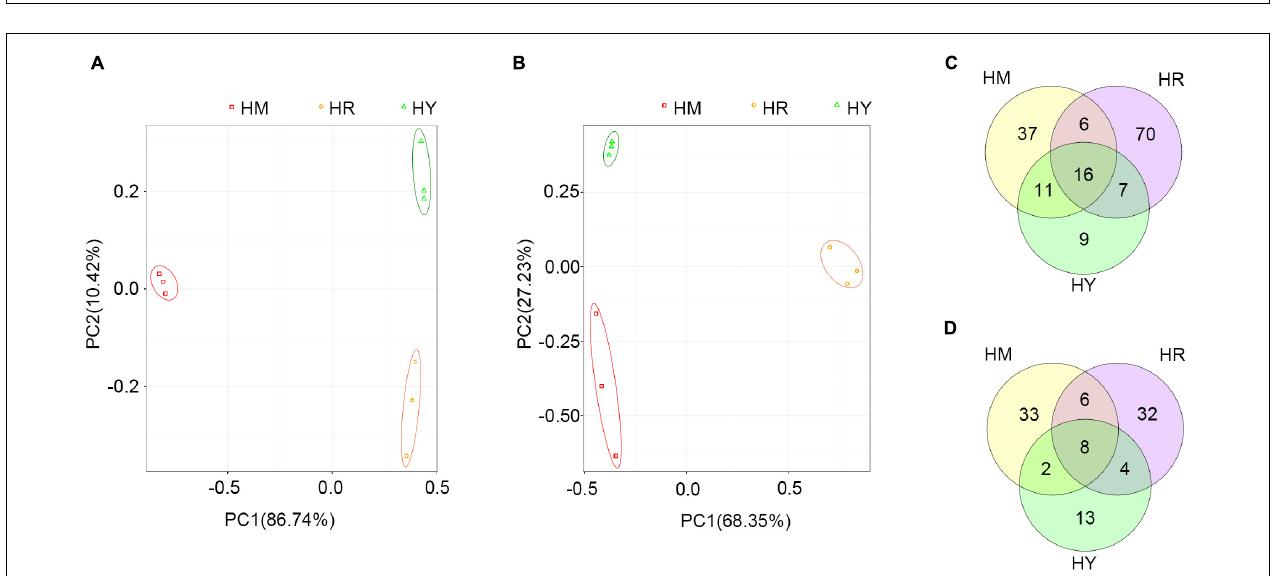
FIGURE 4 | LEfSe analysis of intestinal microbiota in H. axyridis fed with different diet. (A) LEfSe analysis of bacteria. (B) LEfSe analysis of fungi.